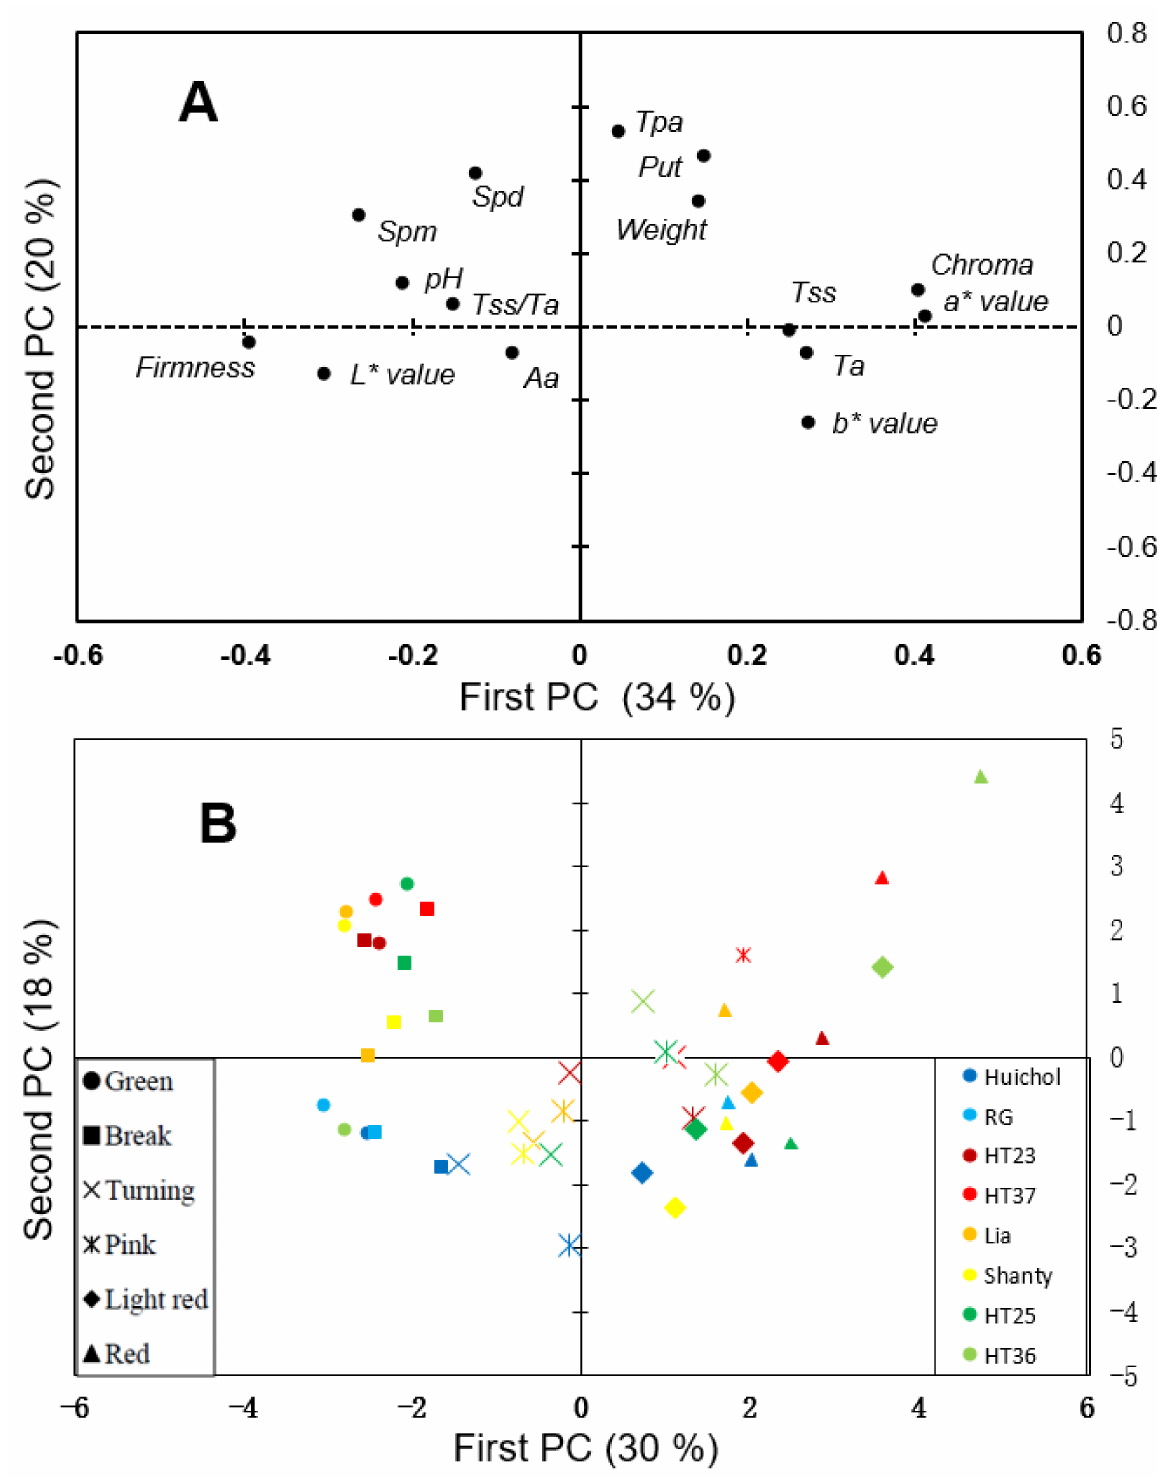
Figure 2. Score ( A ) and loading ( B ) plots generated from PCA on all and mean values, respectively, of quality traits (Chroma (brightness), a* value (redness), b* value (blueness), L* value (lightness), TSS (total soluble sugar), Ta (titratable acidity), TSS / Ta (total soluble sugar and titratable acidity ratio), Aa (ascorbic acid), Firmness, pH and Weight) and polyamines contents ( Tpa (total content of polyamines), Put (putrescine), Spd (spermidine), Spm (spermine)) of eight genotypes ‘Huichol’, ‘Rio Grande (RG)’, ‘HT23’, ‘HT37’, ‘Lia’, ‘Shanty’, ‘HT25’, and ‘HT36’ (marked with different colors) at six maturity stages (marked with different symbols). Loading plot on data from each tomato evaluated are shown in Figure